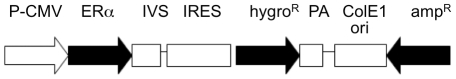
Map of pIRES-ERα bicistronic plasmid.The vector contains a single mammalian transcription unit initiating from the CMV immediate early promoter and terminating with an SV40 derived polyA addition fragment.